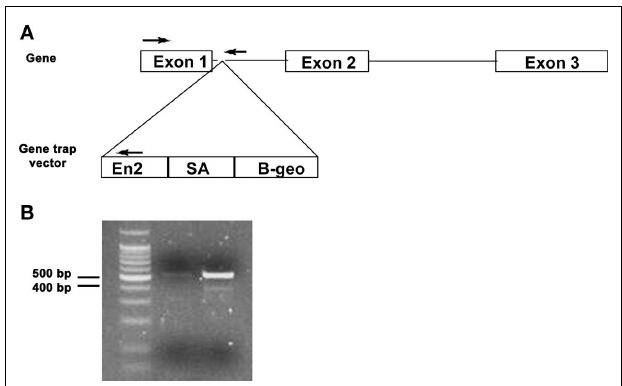
FIGURE 2 | Schematic of gene trap vector and PCR genotyping of Mthfs gt allele. (A) Schematic of Mthfs gene, which consists of three exons. The gene trap vector was inserted between exon 1 and 2. PCR priming sites are shown with arrows. (B) PCR products (run on 2% agarose gel) for nuclear tail DNA of Mthfs + / + and Mthfs gt/ + .The wild-type allele produces a 530bp product and the gene trap (gt) allele produces a 400bp